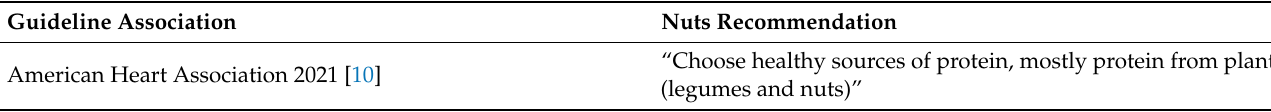
Table 1. Examples of Recommendations for Nuts in CVD Clinical Practice